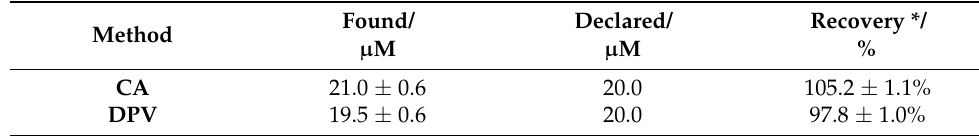
Table 2. Determination of 5-ASA in pharmaceutical